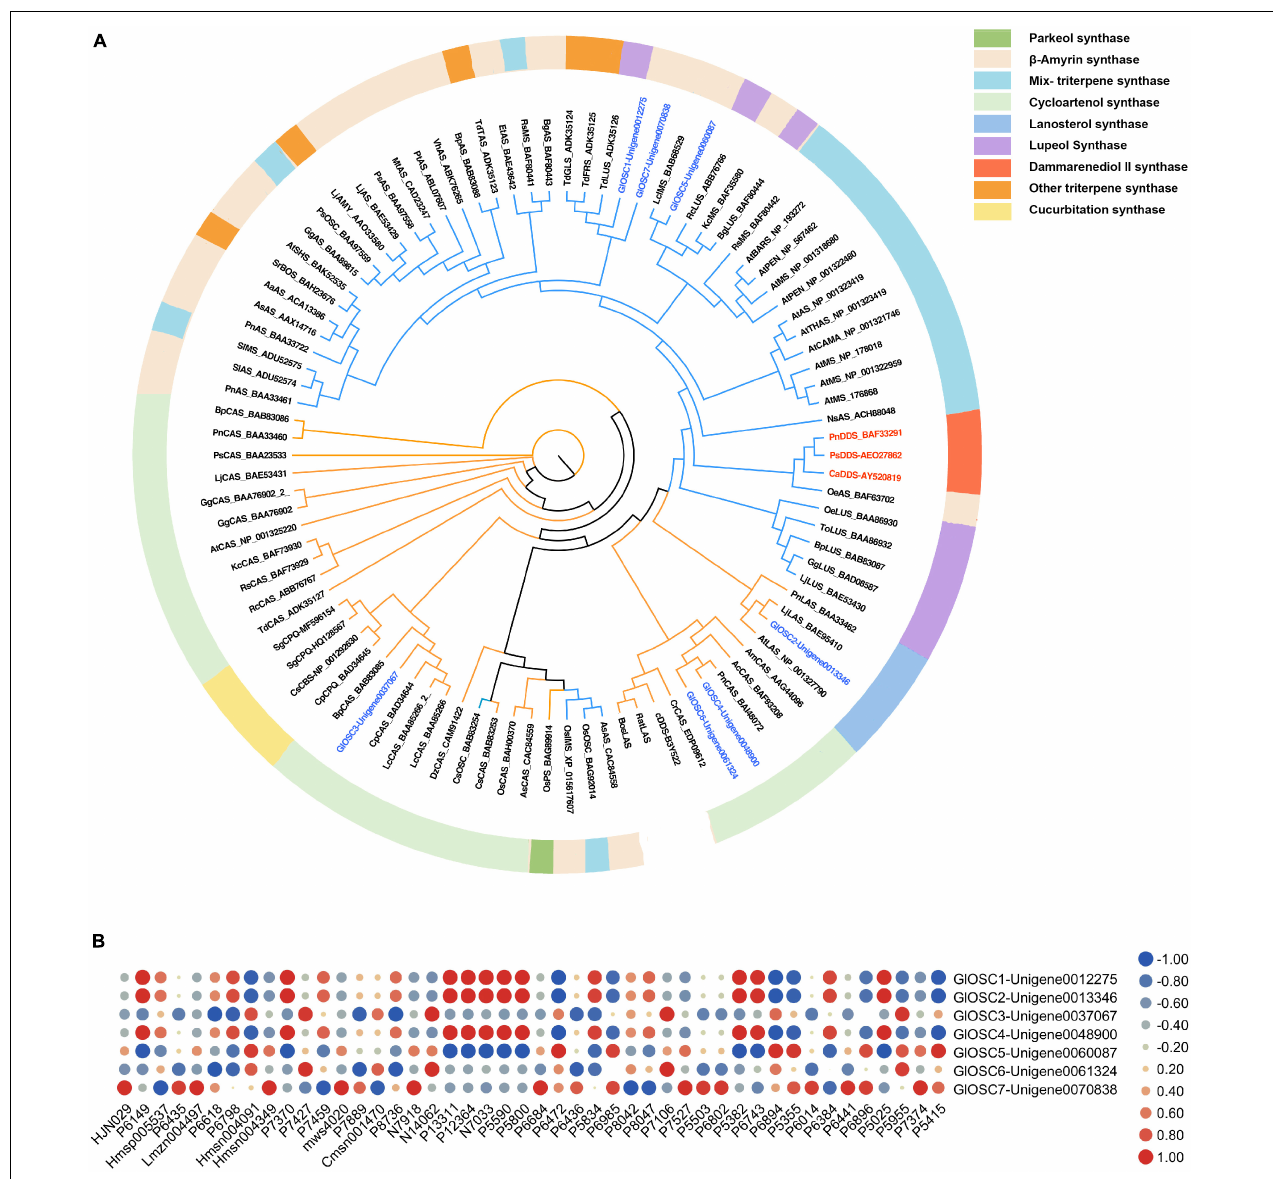
FIGURE 4 | (A) Phylogenetic analyses of the GlOSC s from G. longipes and characterized OSCs from other plants. Their catalytic functions were classified in colors, green: parkeol synthase, light orange: β -amyrin synthase, light blue: Mix-triterpene synthase, light green: cycloartenol synthase, purple: lupeol synthase, red: dammarenediol synthase, orange: triterpene synthase with other functions, light yellow: cucurbitadienol synthase. (B) Pearson correlation analysis between expression level of GlOSC s and content level of triterpenes, the red cycle presented positive correlation, the blue cycle presented negative correlation, and size of cycle presented the degree of